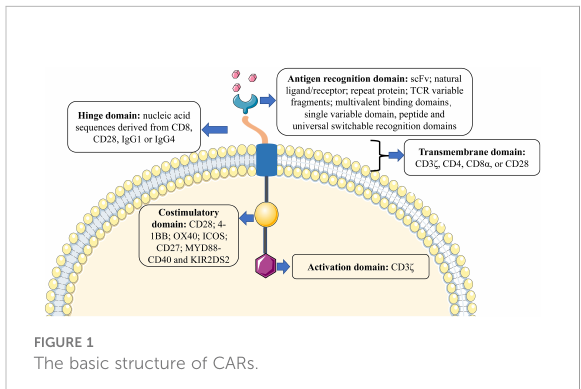
FIGURE 1 The basic structure of